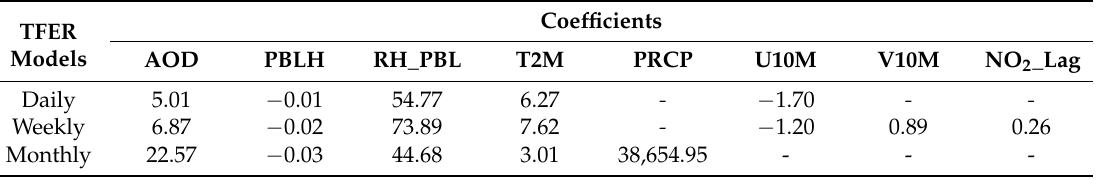
Table 1. Coefficients of independent variables of the first-stage nested TEFR model.